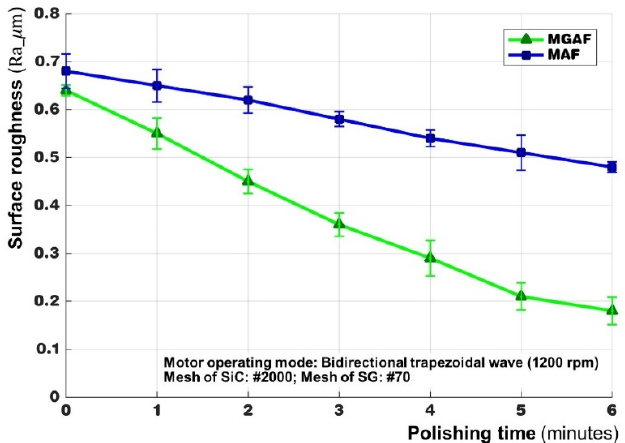
Figure 2. Comparison chart of average surface roughness and polishing time of MGAF and MAF.